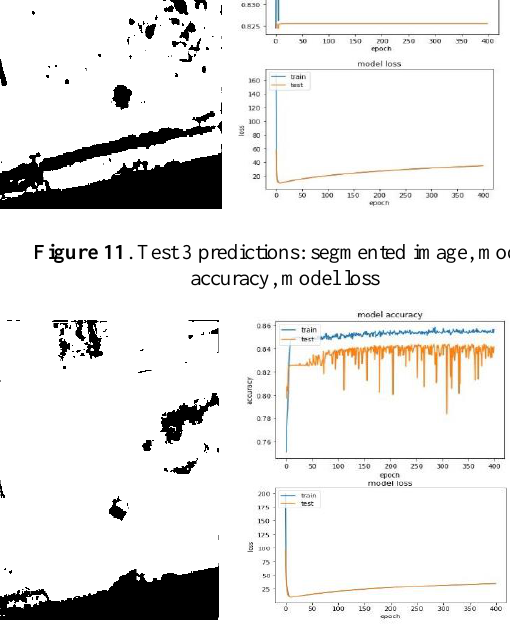
Figure 12 . Test 4 predictions: segmented image, model